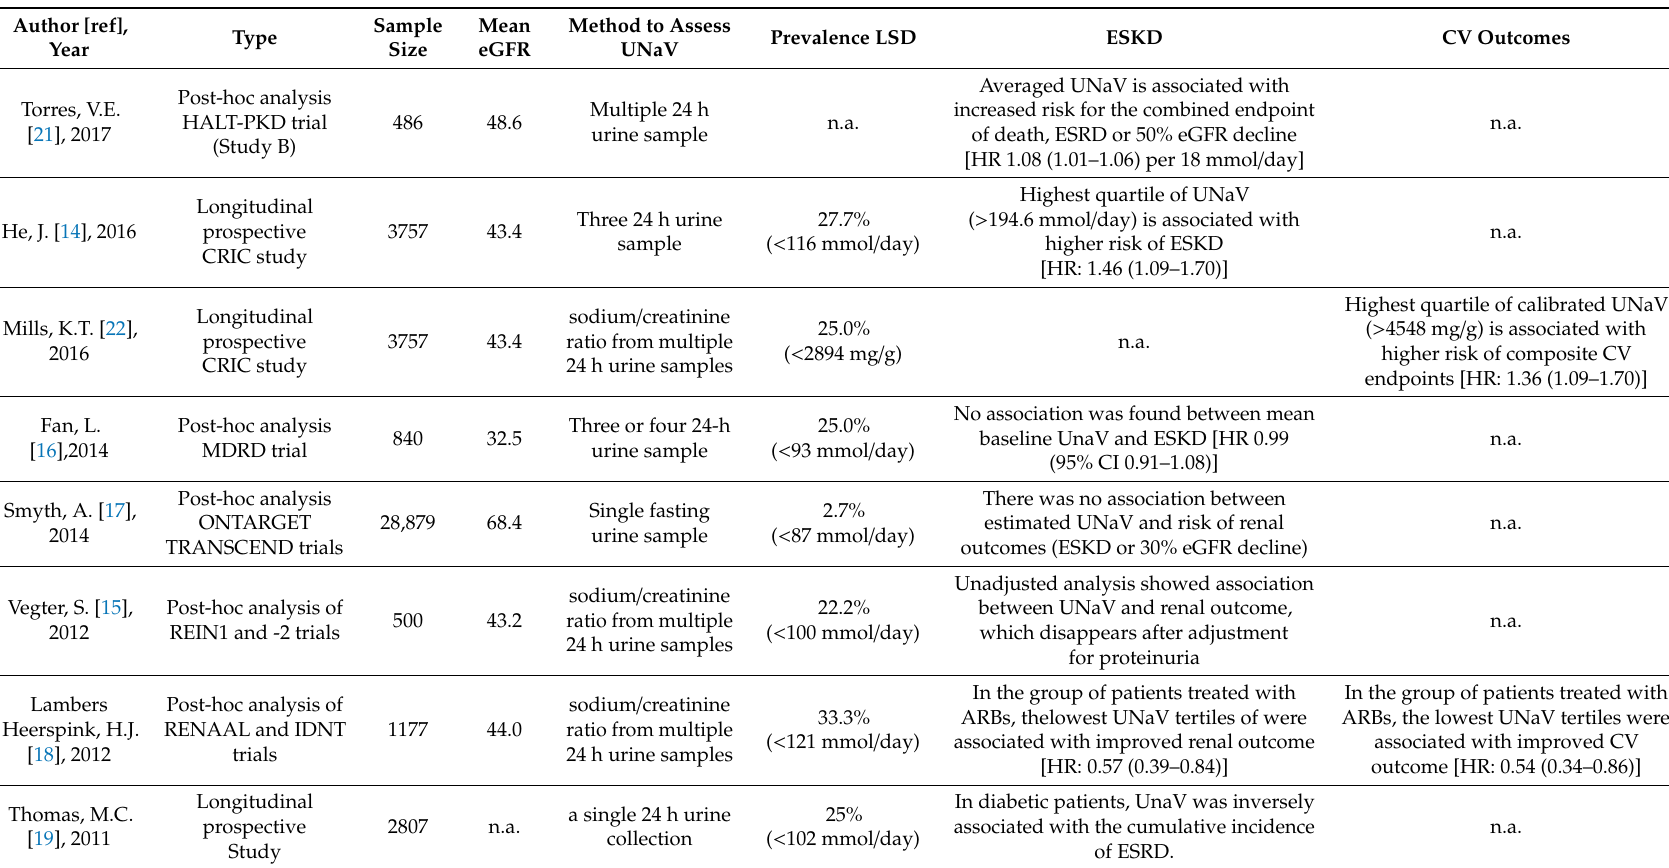
Table 2. Studies evaluating the e ff ect of urinary sodium excretion (UNaV) on end-stage kidney disease (ESKD) and cardiovascular (CV) outcomes in patients with or without Chronic Kidney Disease